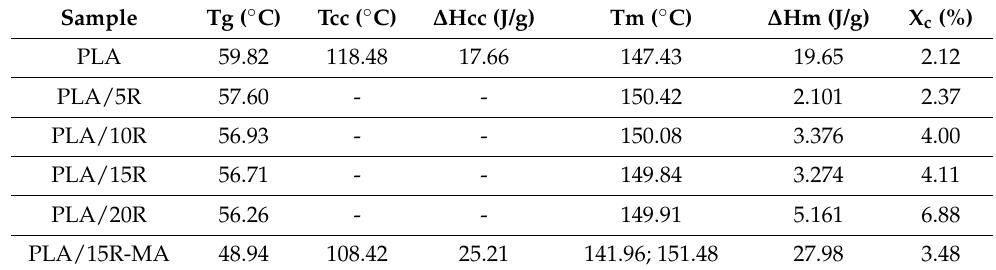
Table 3. Thermal parameters resulted from the second heating DSC scans of neat and plasticized